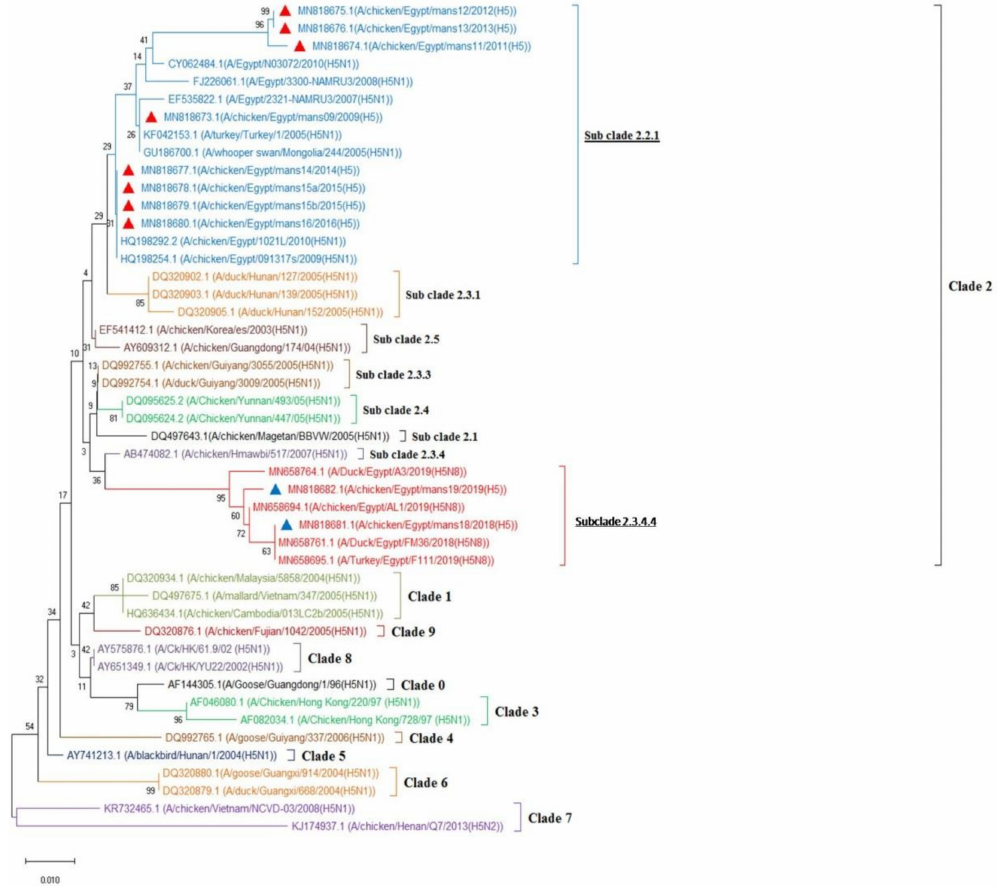
Figure 4. The phylogenetic neighbor-joining tree of 9 AIV clades designed by MEGAX software. The alignment of obtained nucleotides sequences of 10 selected samples shows that the strains mans9, mans11, mans12, mans13, mans14, mans15a, mans15b, and mans16 (red triangles) identified in the present study are closely related to other Egyptian H5N1 viruses as they were aligned in the Egyptian sub clade 2.2.1 containing H5N1 AIVs. The strains mans18 and mans19 (blue triangles) are aligned in the new Egyptian sub clade 2.3.4.4, together with other Egyptian